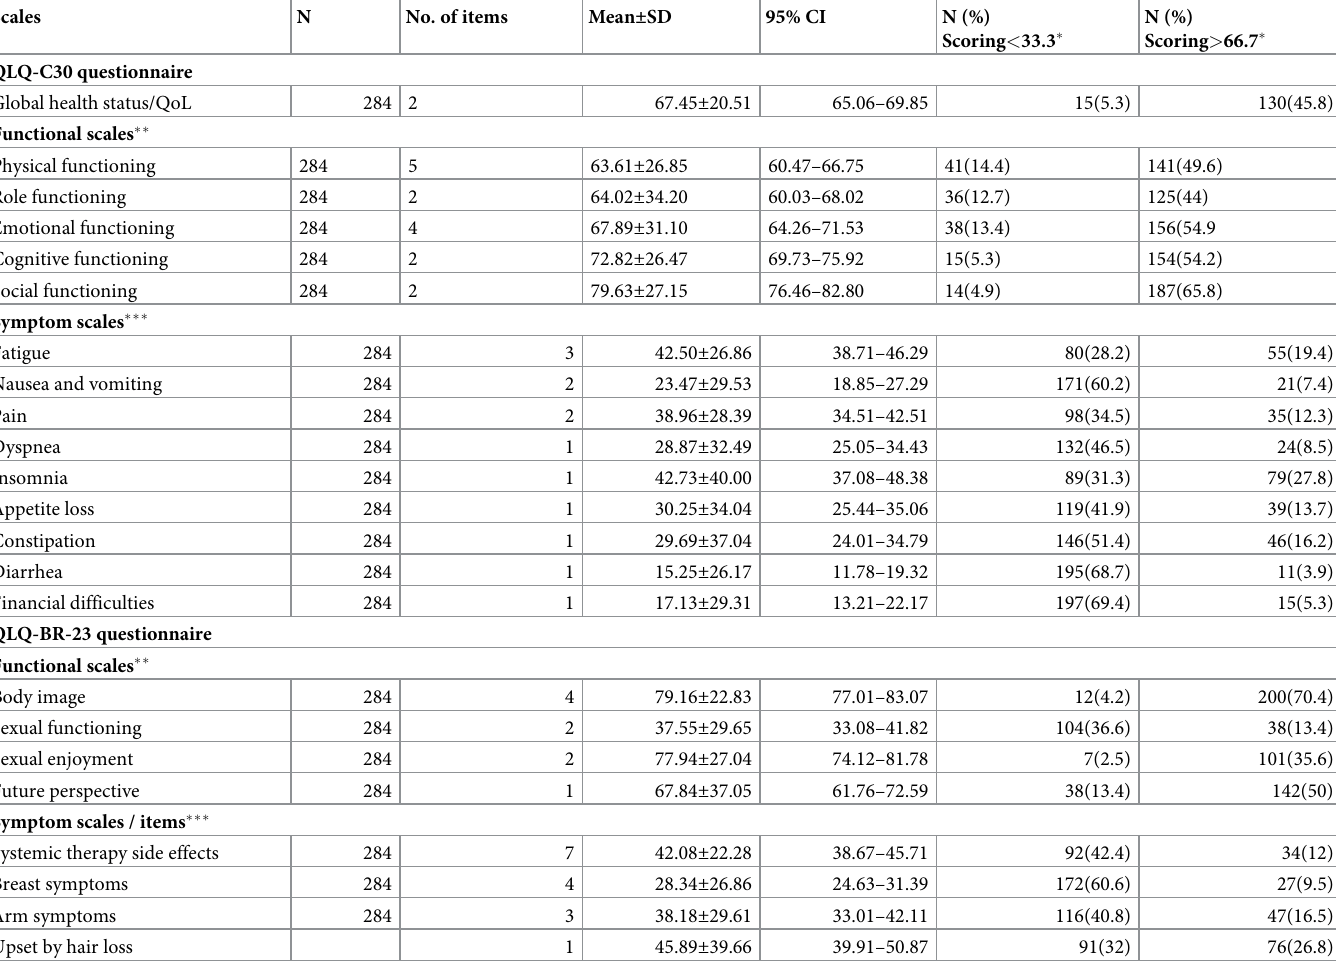
Table 2. Assessment of quality of life in breast cancer survivors by using EORTC QLQ-C30 and QLQ-BR-23 questionnaires.